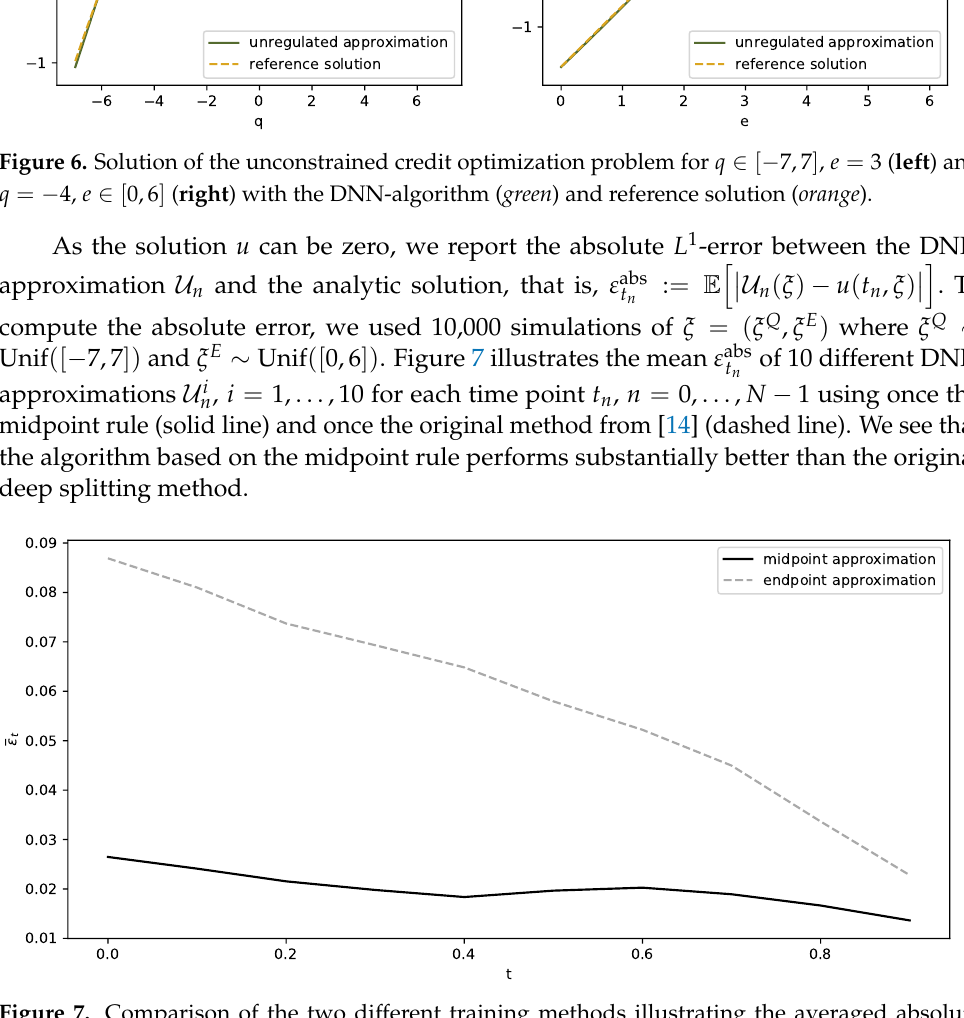
Figure 7. Comparison of the two different training methods illustrating the averaged absolute L 1 -error ¯ ε abs using endpoint ( grey ) and midpoint ( black ) approximation in 10 training t